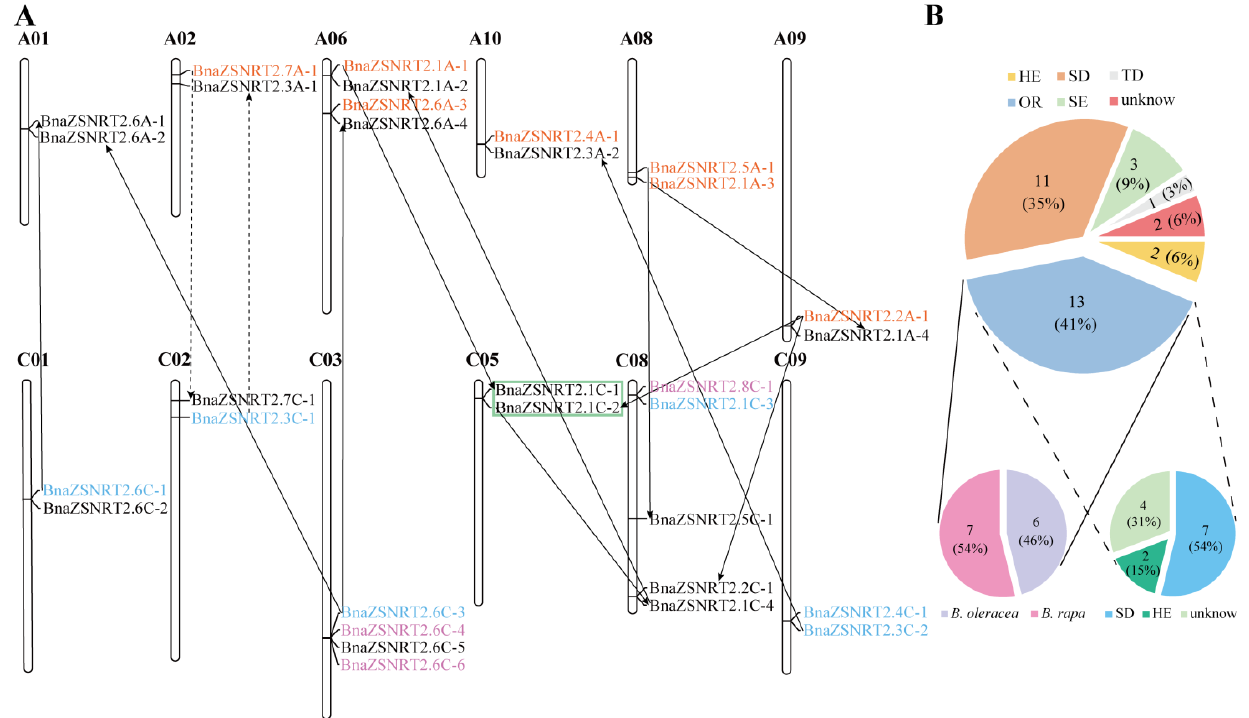
Figure 2. Chromosome distribution and duplication of BnaZSNRT2s . ( A ) 31 BnaZSNRT2s were mapped on 12 chromosomes in B. napus . The genes in orange and blue originated from B. rapa and B. oleracea, respectively; genes in purple were involved in segmental exchange (SE) events; the genes with green frames were tandem duplication (TD) pairs. The black and dashed lines with an arrow represent the duplication direction of genes involved in segmental duplication (SD) and homologous exchange (HE) events, respectively. ( B ) The big pie chart represents the percentage of BnaZSNRT2s derived from SD, SE, HE, TD, and orthologous region (OR) events, respectively; the left small pie chart represents the percentage of BnaZSNRT2s from OR and then experienced small duplication events in B. napus , and the right small pie chart represents the percentage of BnaZSNRT2s involved in OR events from B. rapa and B. oleracea .